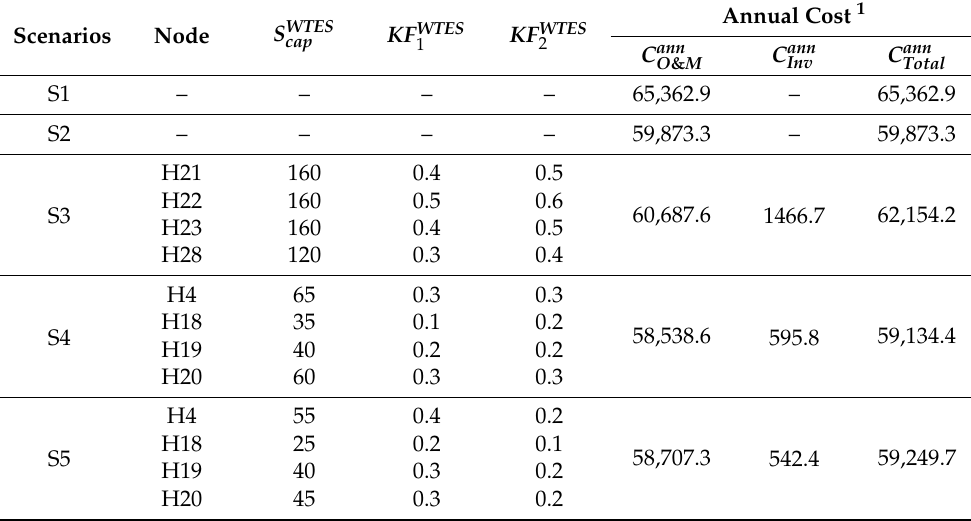
Figure 5. Structure diagram of the UEHIES in the case study. Table 2. Optimization results of configuration schemes of